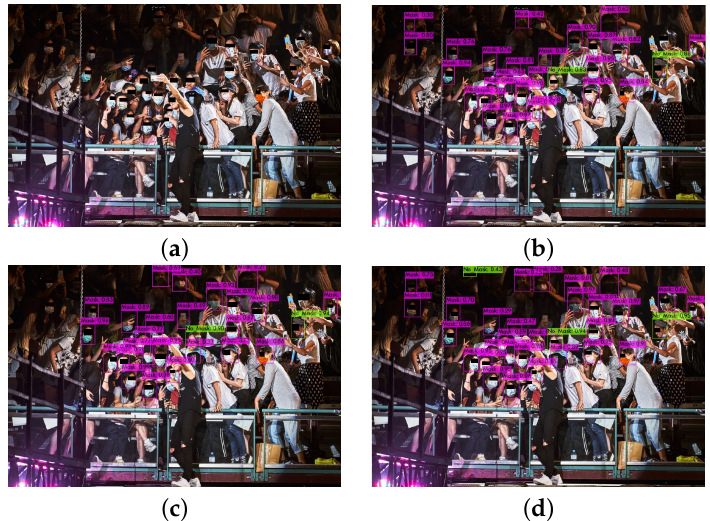
Figure 8. ( a ) Initial image and the classification results of ( b ) YOLOv3, ( c ) YOLOv4, and ( d ) YOLOv4-tiny.